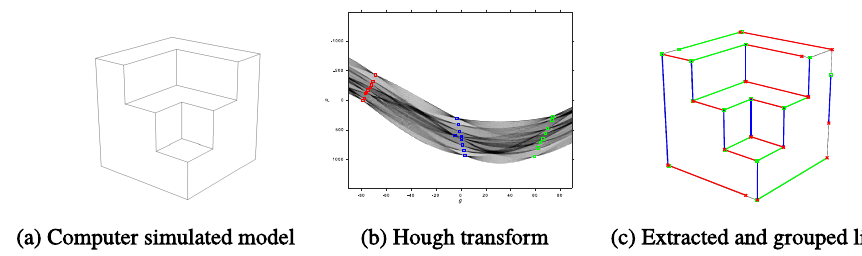
Figure 7. Line detection and grouping using the proposed cascade Hough transform. ( a ) Output image; ( b ) High peaks (squares) in the first Hough transform are grouped in the second Hough transform; ( c ) Three groups of lines are marked with green, yellow, and red, respectively. The initial vanishing points are then used with selected feature points for searching for corresponding base points. A step-by-step base point estimation process is illustrated in Figure 8. All selected blue feature points are first projected onto the Y − Z plane from V x , marked as red triangles (Figure 8a). Those red triangles are further projected to the direction of V z onto the Y axis, marked as green triangles (Figure 8b). Finally, the intersection of aV z and lines linked from green triangles to V x indicate the base points (Figure 8c).